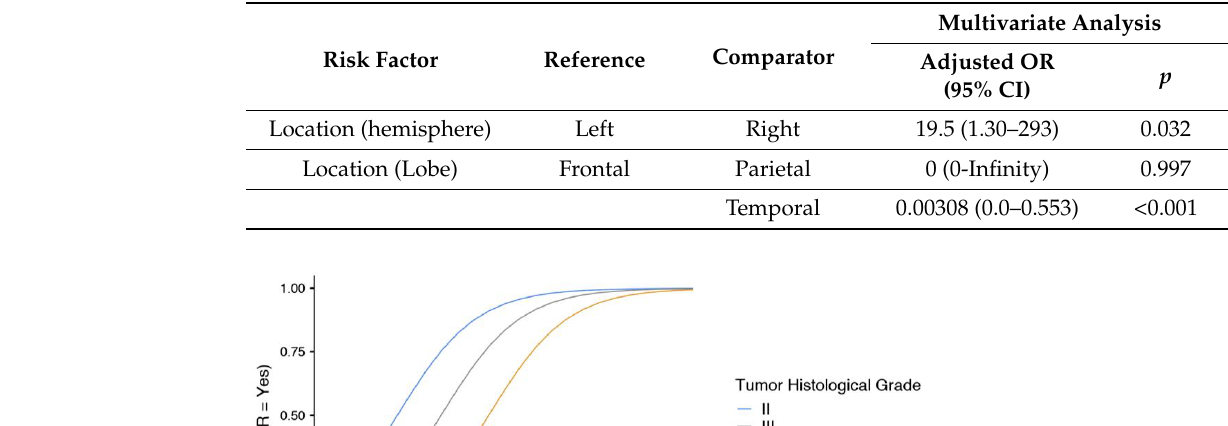
Table 3. The multivariate regression analysis showed that the probability for gross total resection was limited in the left-sided temporal gliomas.